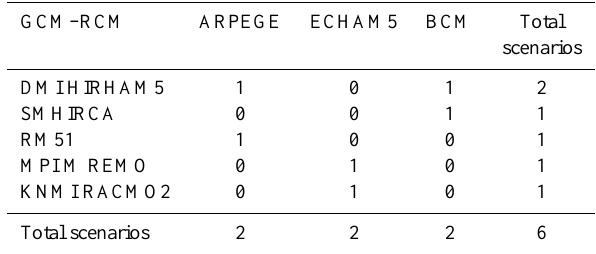
Table 1. GCM and RCM combinations used from ENSEMBLES project. The number denotes number of